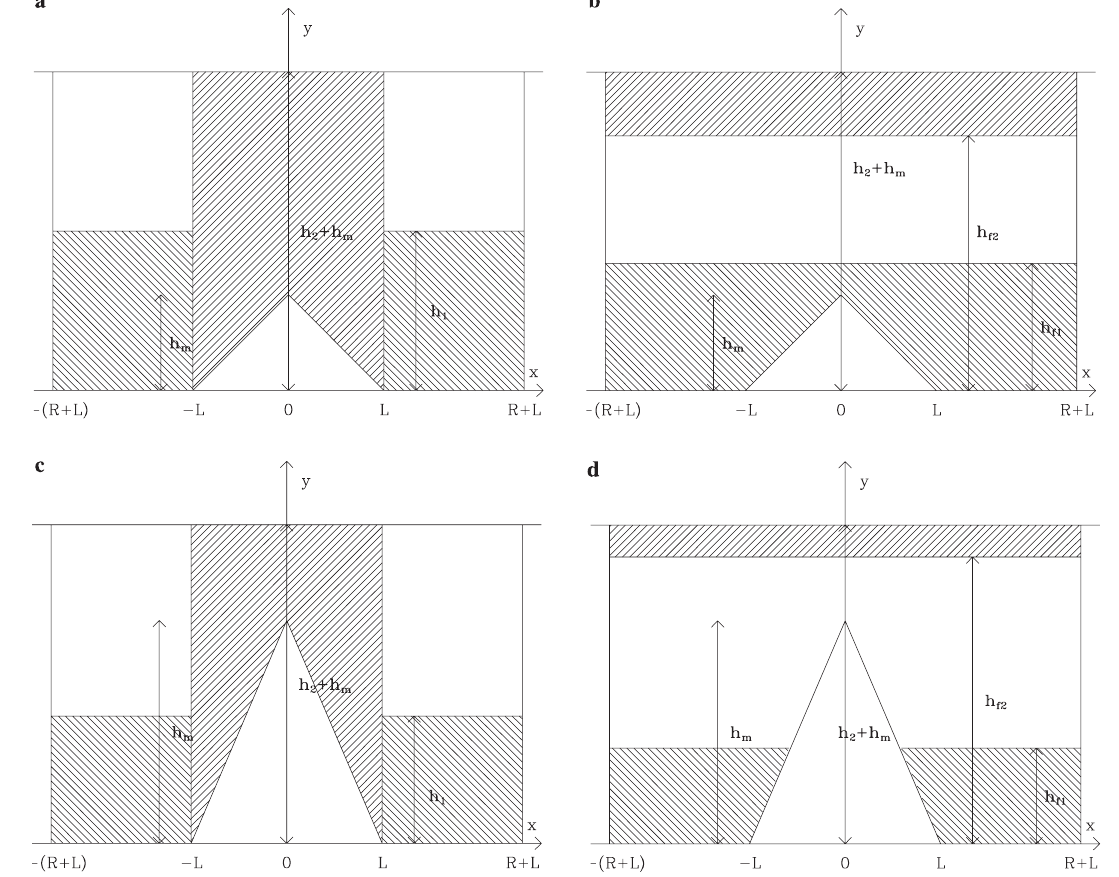
Fig. 5. a Air masses in two heated boundary layer over mountainous terrain, for a small mountain. h m is the mountain height. R and L as in Fig. 3a. h 2 is the boundary layer depth over the mountain and h 1 is the boundary layer depth over the flat terrain. b As in a but after an